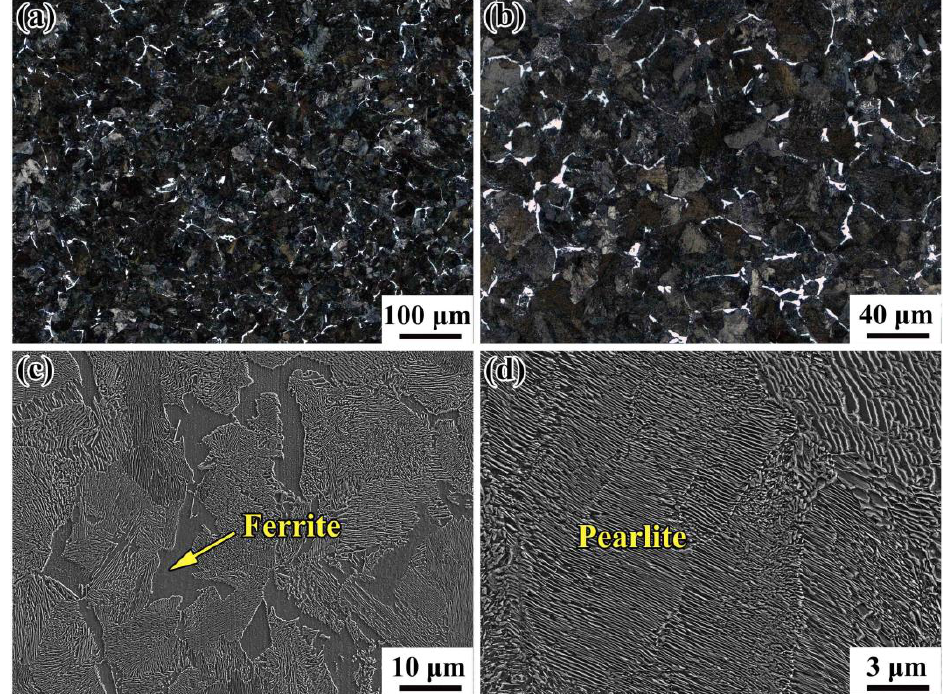
Figure 3. Microstructure of the wheel-steel: ( a , b ) OM (optical microscopy) images of pearlite domains (black regions) and proeutectoid ferrite domains (white regions); ( c , d ) the SEM (scanning electron microscopy) images.